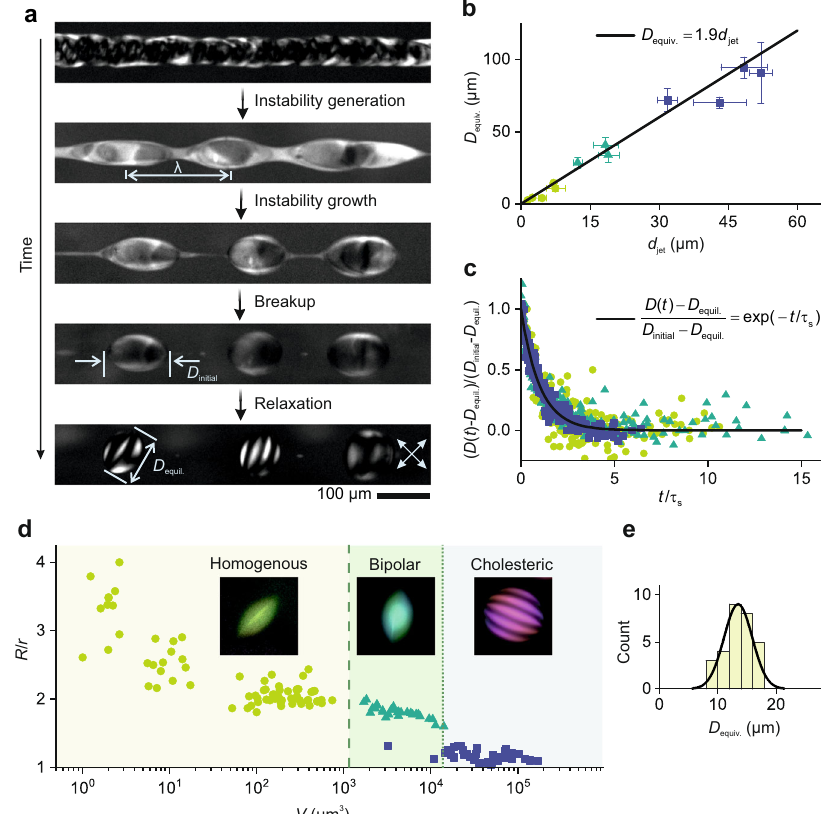
Fig. 2 | The interplay between fl uid fl ow and thermodynamics rules the dynamics oftactoids formation. The fi lled circle, triangle, and square symbols in the plots represent data points from homogenous, bipolar, and cholesteric tac- toids,respectively. a Richdynamicsofformationofthetactoidscapturedunderthe crossed-polarizer: formation of nematic jet, development of Rayleigh-Plateau instability with wavelength λ , the breakup of jet, and shape and structural relaxa- tion of tactoids with initial length of D initial and equilibrium length of D equil . The crossed arrows denote the crossed polarizers. b Experimental data of equivalent diameter D equiv. (=2 V 1/3 where V = r 2 R is the scaled volume of tactoids with R and r majorandminoraxesoftactoids,respectively)asafunctionofthejetdiameter d jet . The prediction (solid line) is in good agreement, without fi tting parameters, with